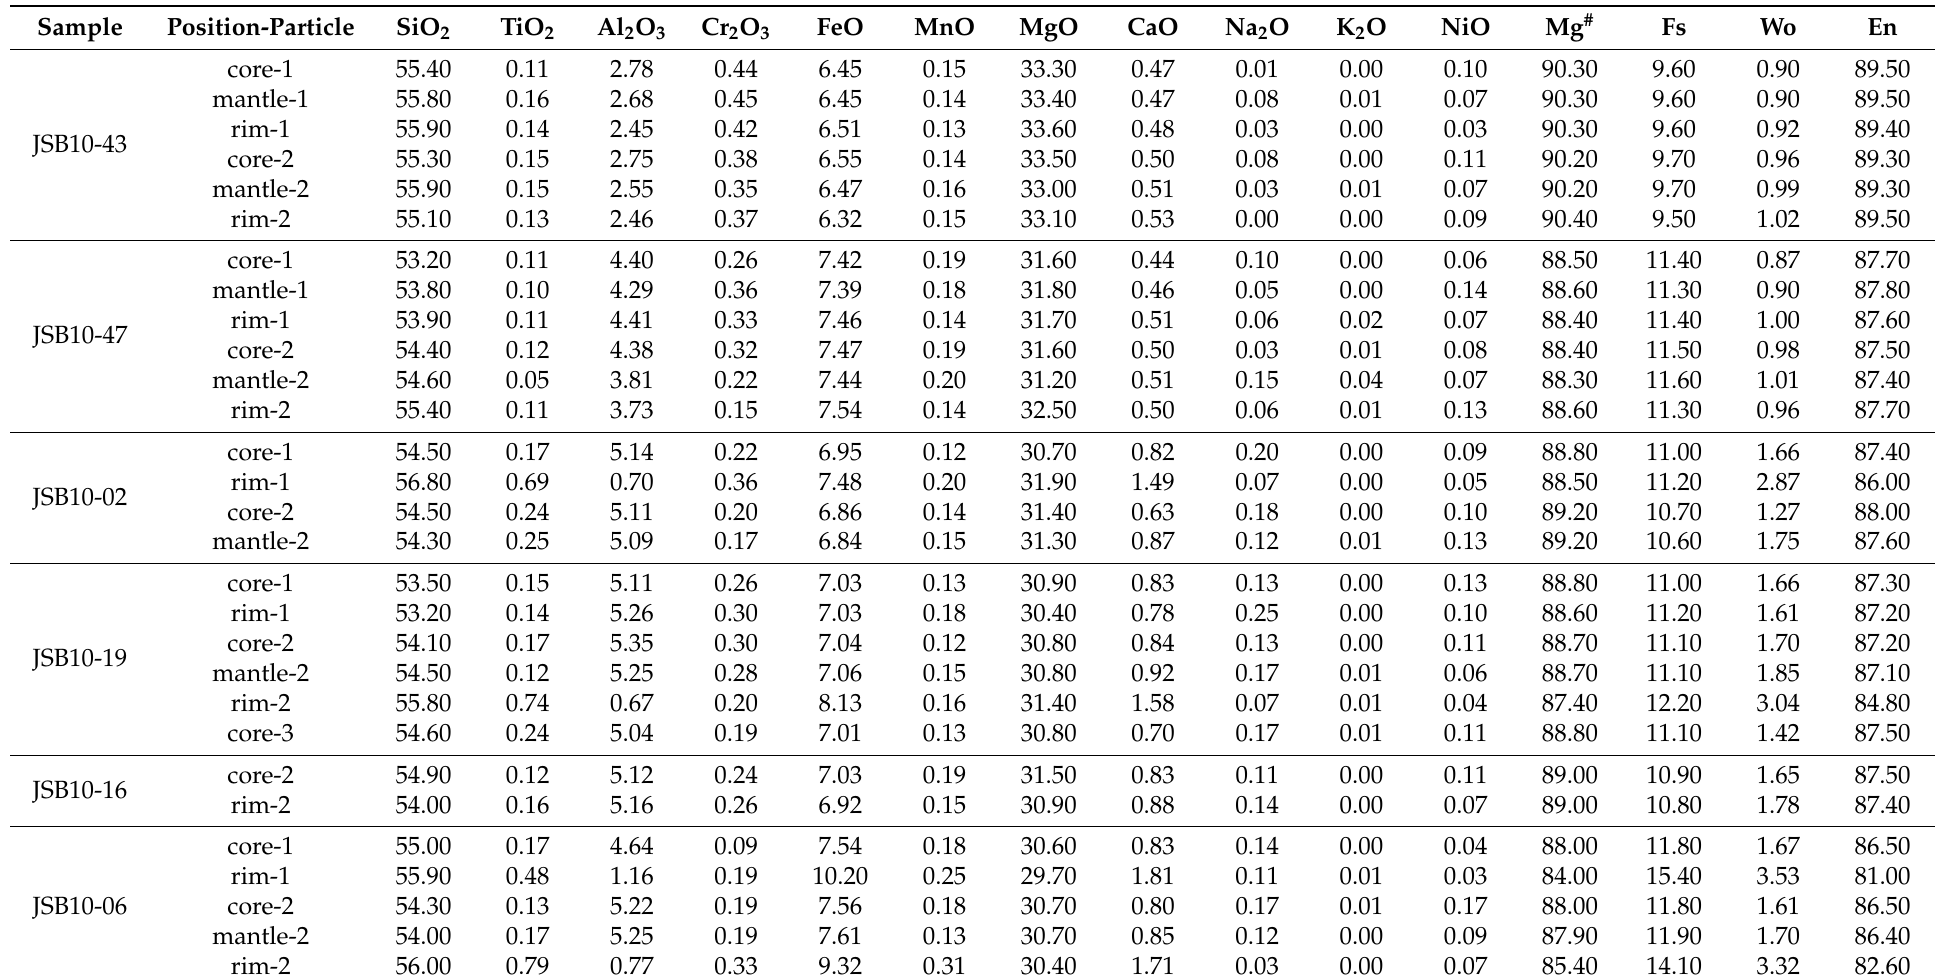
Table 2. The major element composition of orthopyroxene (Opx) in the websterite determined by